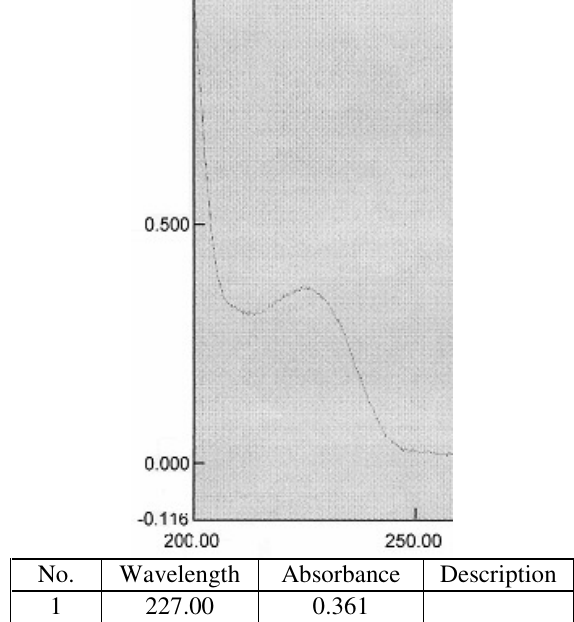
Figure 1. UV absorbance spectrum for ibutilide